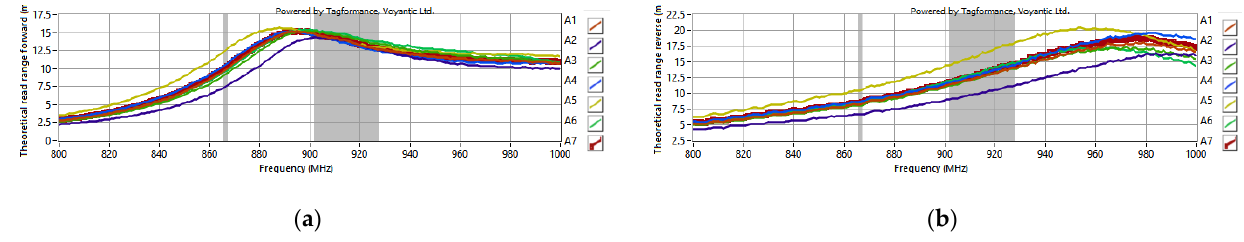
Figure 22. A1 – A7 samples: range of energy ( a ) and data ( b ) transmission in RFID system. Figure 22. A1–A7 samples: range of energy ( a ) and data ( b ) transmission in RFID